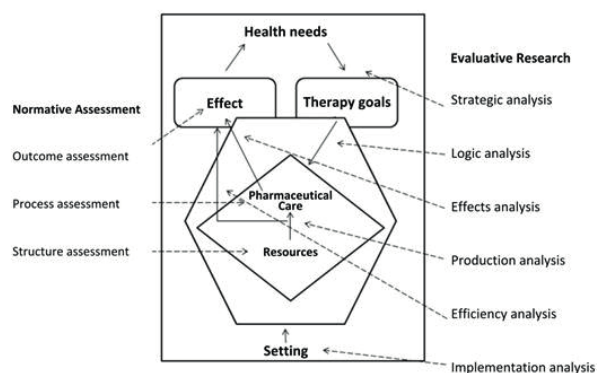
FIGURE 3 - Components of a health intervention.